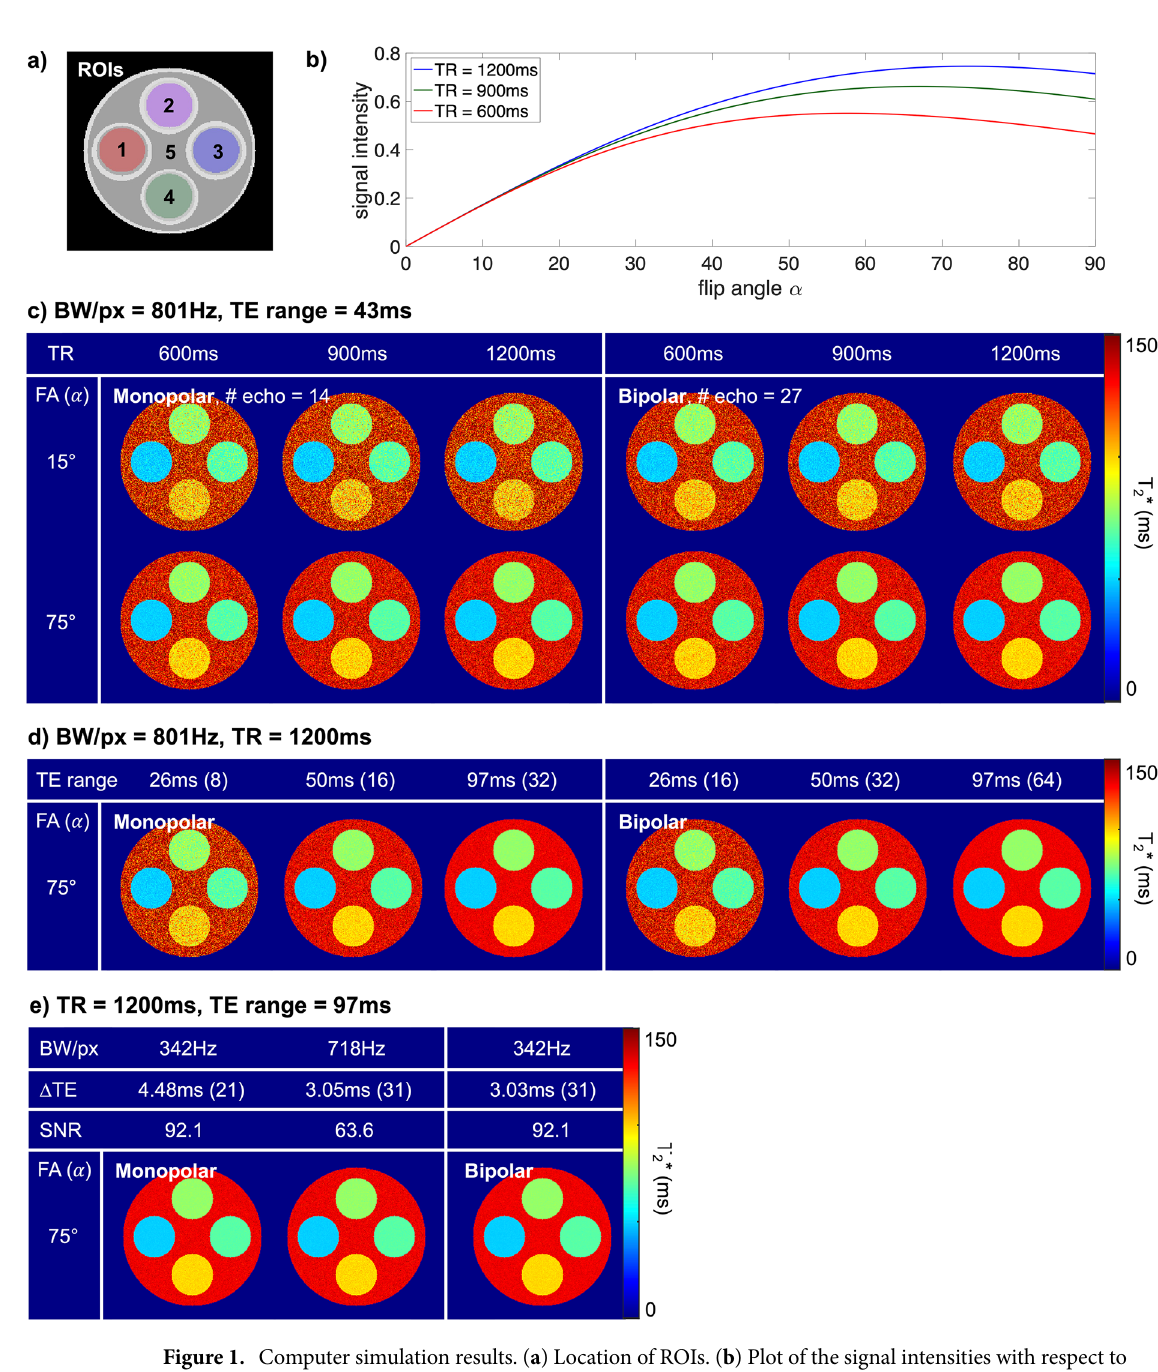
Figure 1. Computer simulation results. ( a ) Location of ROIs. ( b ) Plot of the signal intensities with respect to α in ROI 3. The TRs of 600 ms, 900 ms and 1200 ms are denoted by red, green, and blue lines, respectively. ( c ) T2* maps with respect to the TR. The ∆TE was 2.92 ms for the monopolar readouts and 1.47 ms for the bipolar readouts with a BW/px of 801. To solely observe the effect of SNR, the TE range was limited to 43 ms for all TRs. ( d ) T2* maps with respect to the TE range. As the TE range increases, the variation in the T2* map decreases due to the increased number of echoes. ( e ) T2* maps with respect to BW. The ∆TE decreases with an increase in the BW, allowing more echoes to be collected in a given TE range, but reducing respectively (Fig. 1a). The imaging parameters used in each simulation are summarised in Table S1. For the first simulation, the BW and TE range were fixed to 192.24 kHz and 43 ms. Datasets were generated with three dif- ferent values of α and TR. For the second simulation, the BW, TE range and TR were fixed to 192.24 kHz, 97 ms and 1200 ms. Datasets were created with α values of 15°, 35° and 75°. After creating a total of three datasets for each readout, subsampling was performed along the TE dimension. The first n echoes out of the echoes created were selected and used for T2* quantification. The parameter n was increased from 3 to 32 for monopolar read- outs and from 5 to 64 for bipolar readouts (i.e., we can observe the situation where the TE range was increased